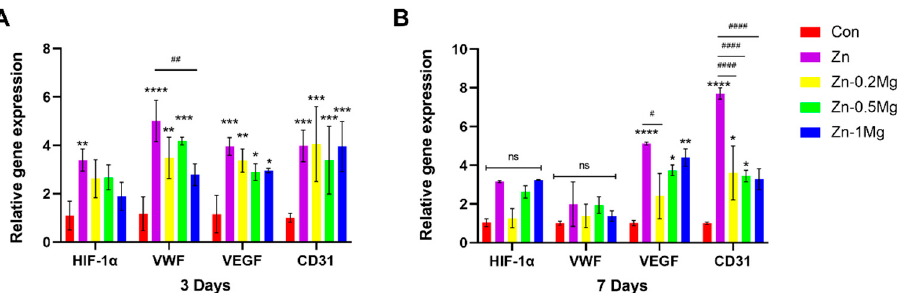
Figure 8. Expression of genes related to angiogenesis. Gene expression in VECs after ( A ) 3 days and ( B ) 7 days in various sample extracts (**** p < 0.0001, *** p < 0.001, ** p < 0.01, * p < 0.05 compared to the control group; #### p < 0.0001, ## p < 0.01, # p < 0.05 compared with the Zn group; (ns) indicates no statistical significance.).